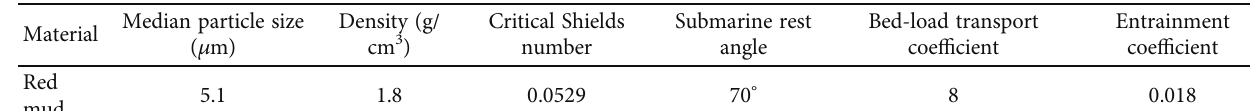
Figure 12: The schematic diagram of erosion mechanism under mud-water mixture fl ow: (a) an illustration of the pre-erosion process and (b) a description of the ongoing erosion process. Table 4: Properties of the tailings.